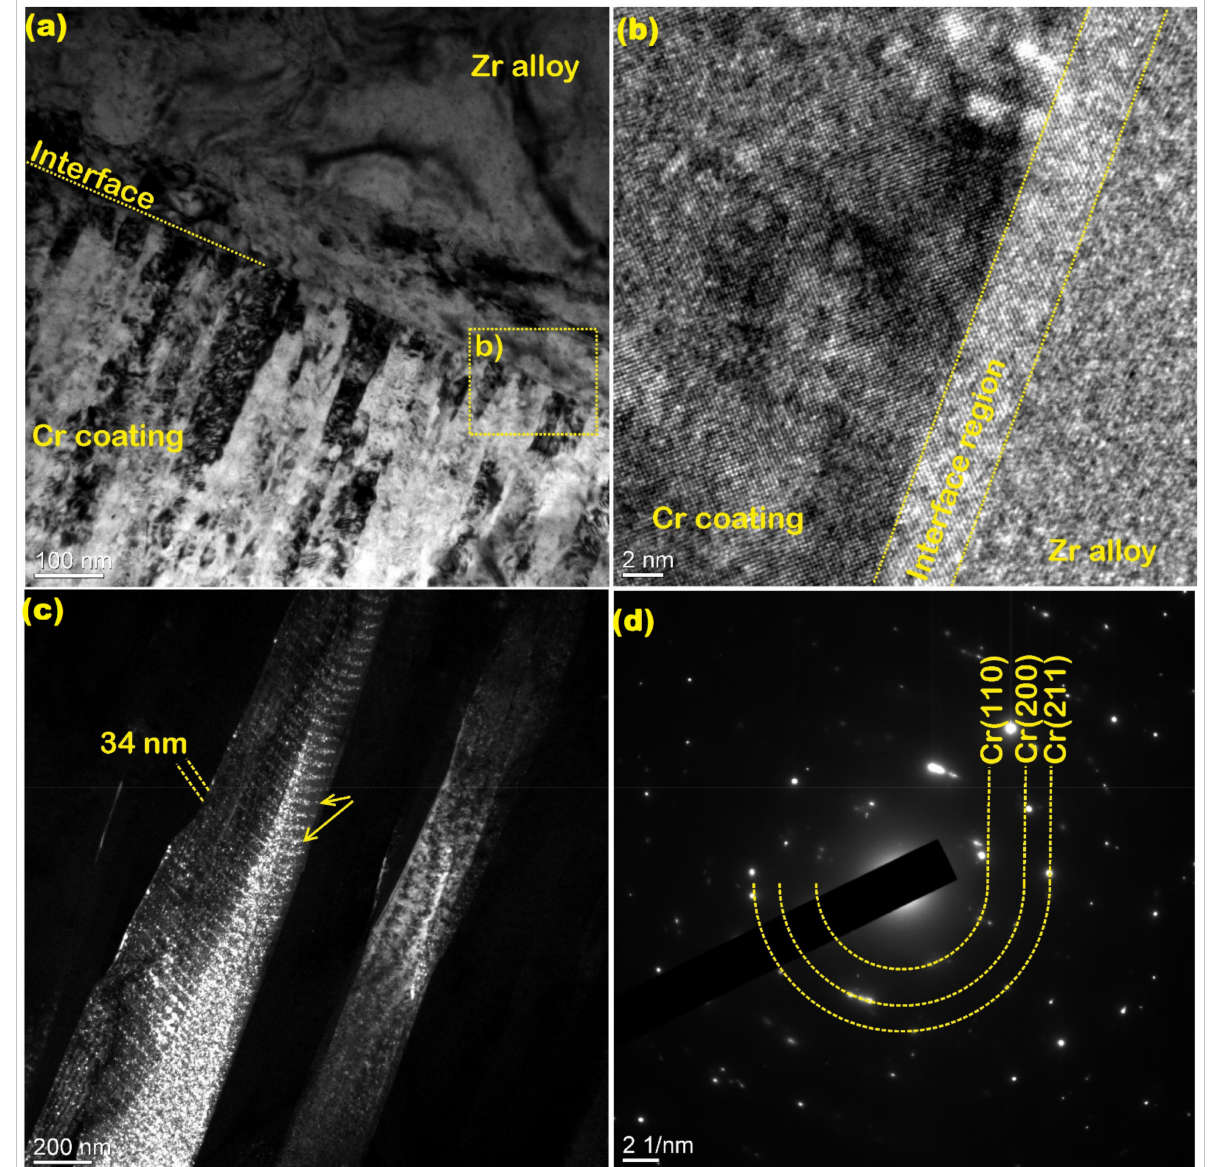
Figure 5. TEM images of the Cr coating deposited on Zr alloy substrate (deposition mode 4): ( a , b )— cross-sectional microstructure in interface region; ( c )—cross-sectional microstructure in Cr coating region; ( d )—SAED